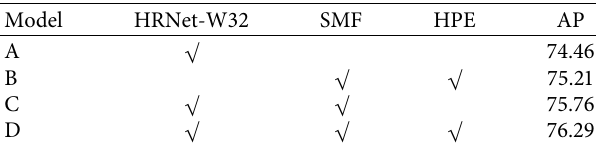
Figure 3: Geometric relations of human body joints. Table 7: Analysis of ablation